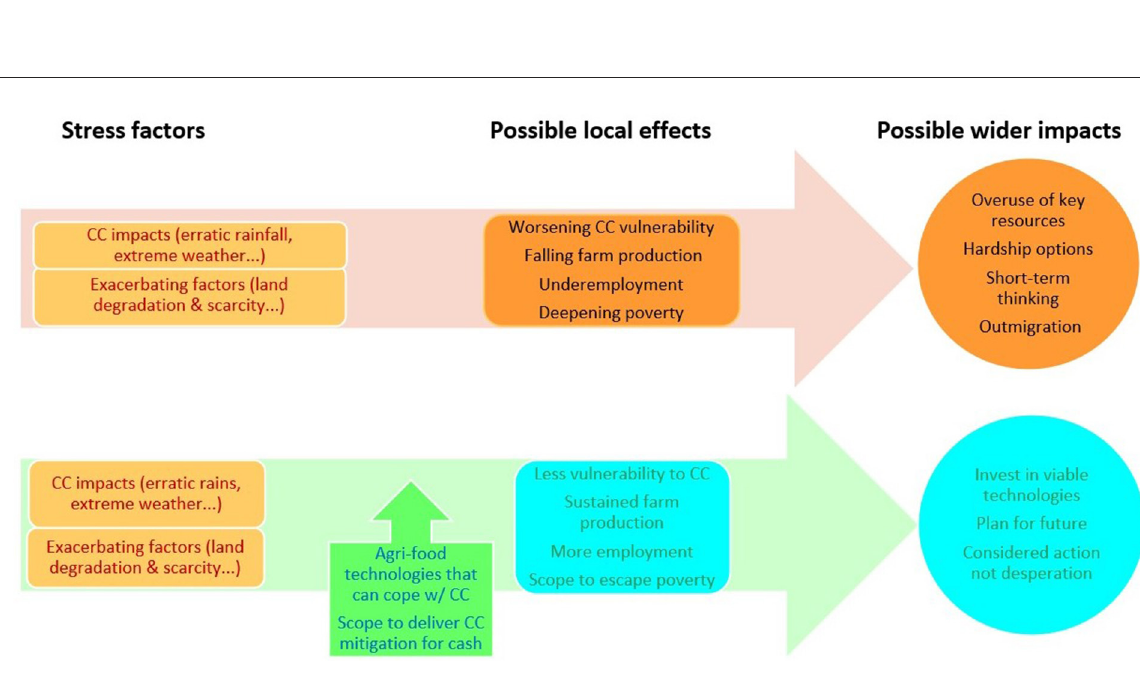
FIGURE5 Differing effects of CC on vulnerable small-scale farmers depending on whether they can access viable